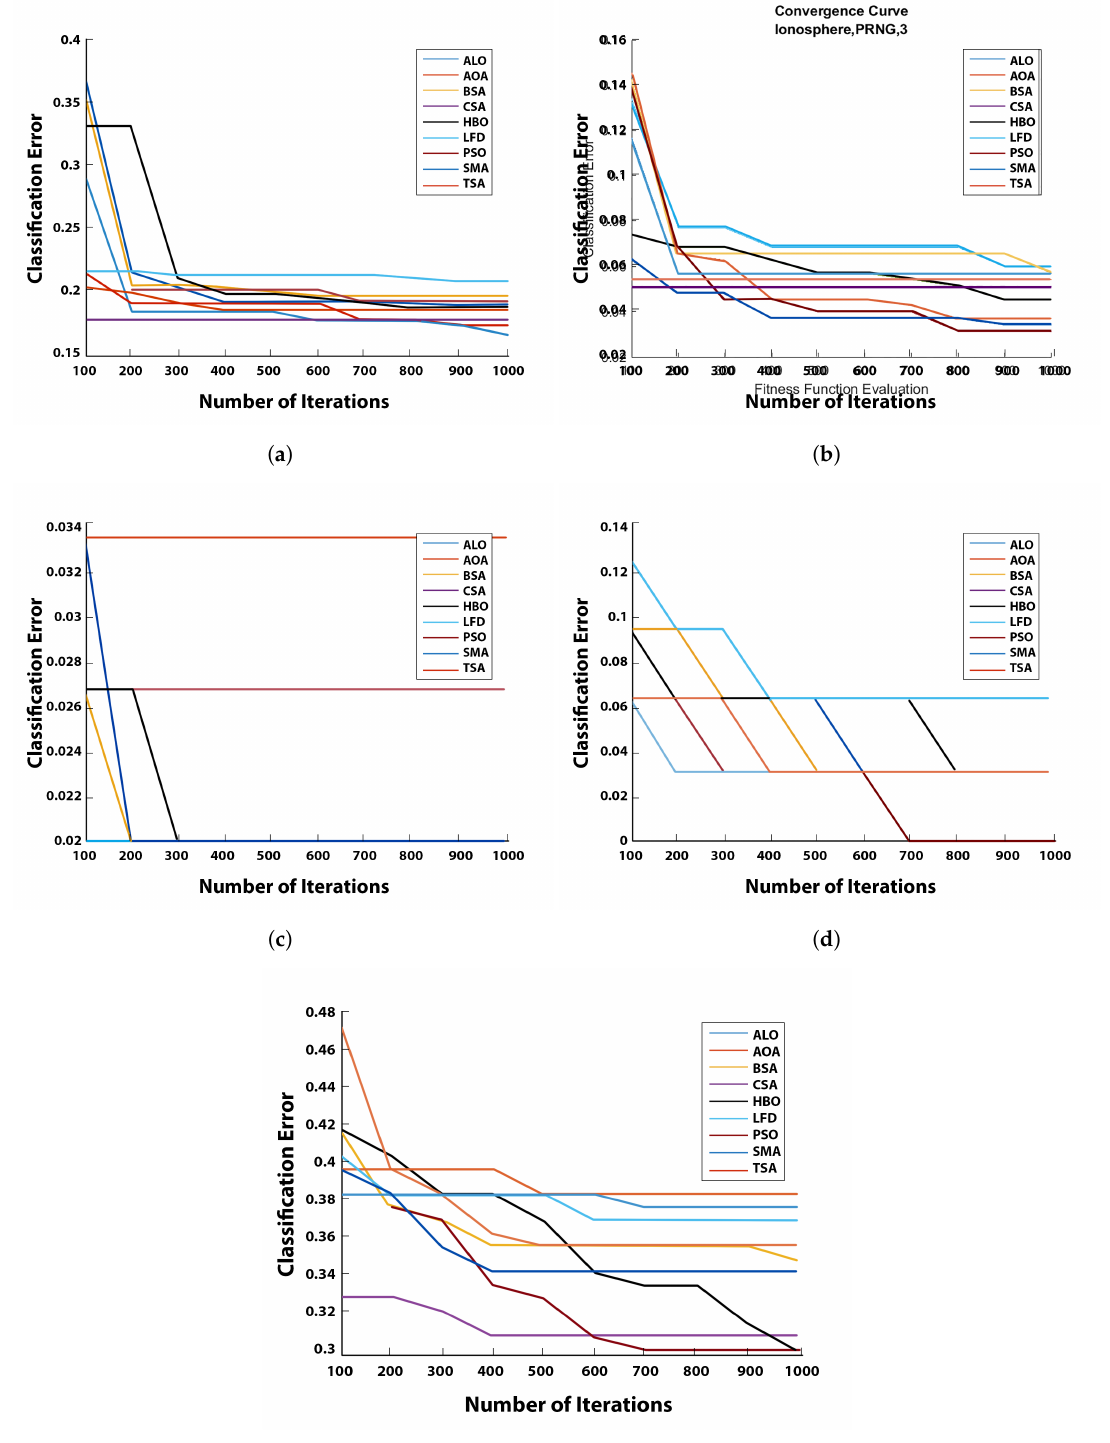
Figure 4. ( a ) Convergence Curve of the proposed approach for Hillvalley dataset; ( b ) Convergence Curve of the proposed approach for Ionosphere dataset; ( c ) Convergence Curve of the proposed approach for Iris dataset; ( d ) Convergence Curve of the proposed approach for Lung-Cancer dataset; ( e ) Convergence Curve of the proposed approach for Lymphography